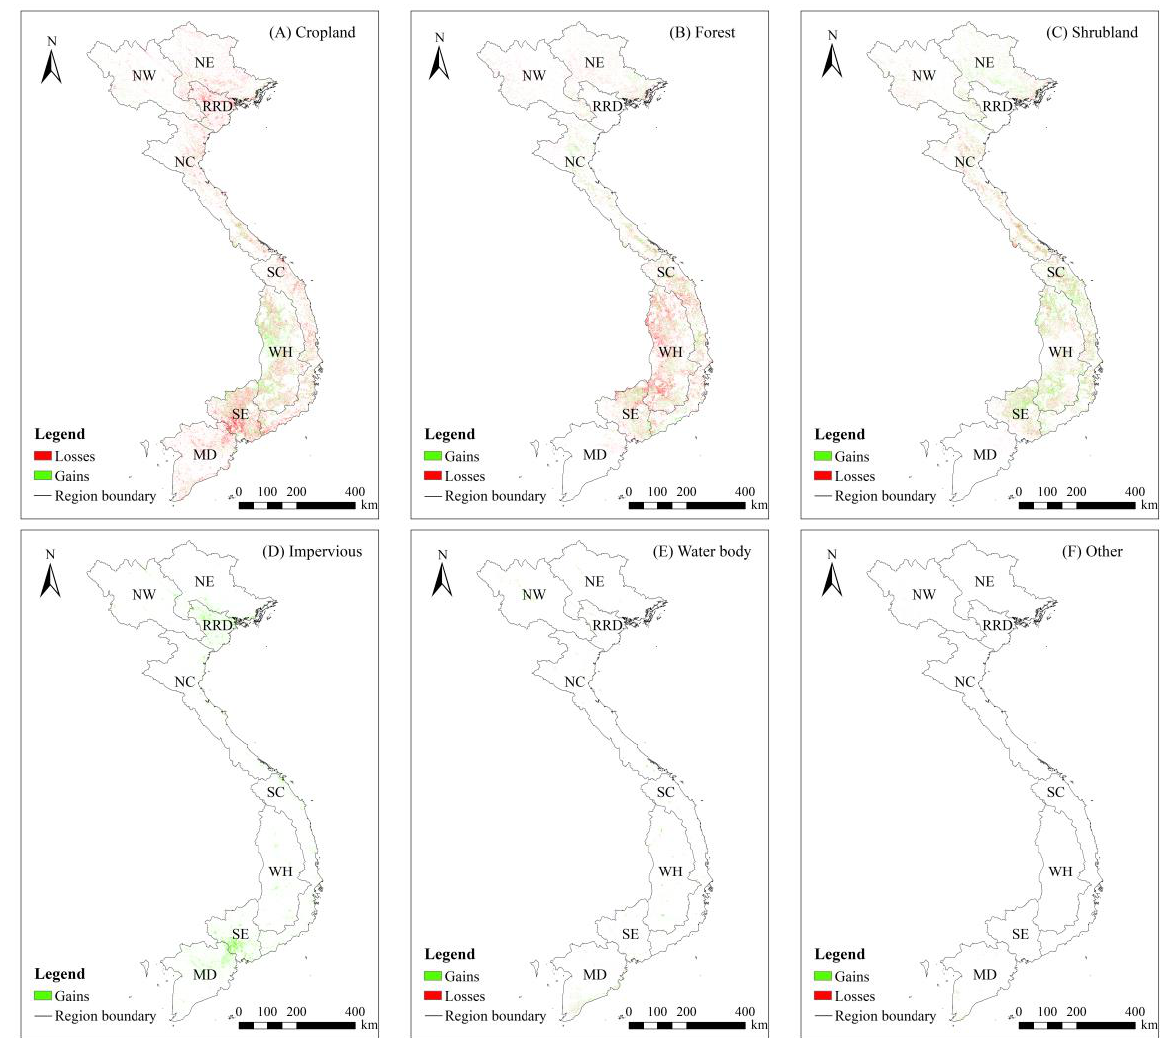
Figure 5. Spatial distributions of different LULC gains/losses during 2000—2020. ( A ), Cropland; ( B ), Forest; ( C ), Shrubland; ( D ), Impervious; ( E ), Water body; ( F ), Other.